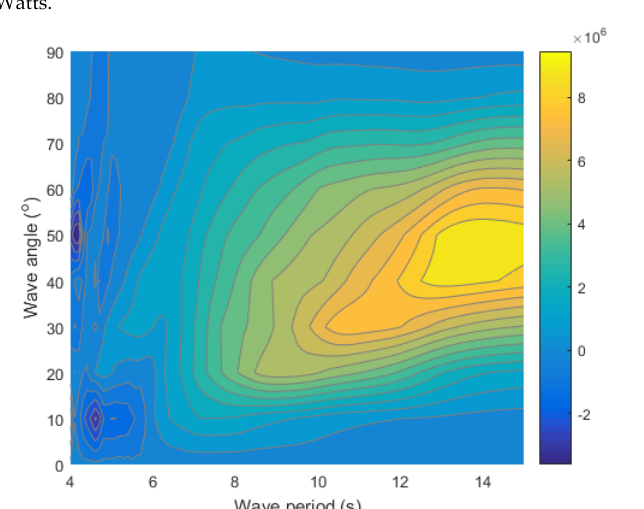
Fig. 10. Power extraction through joint yaw motions, measured in